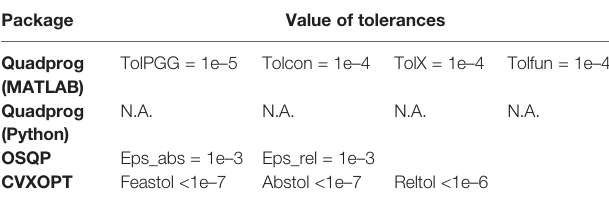
TABLE 4 | Optimization package tolerances.